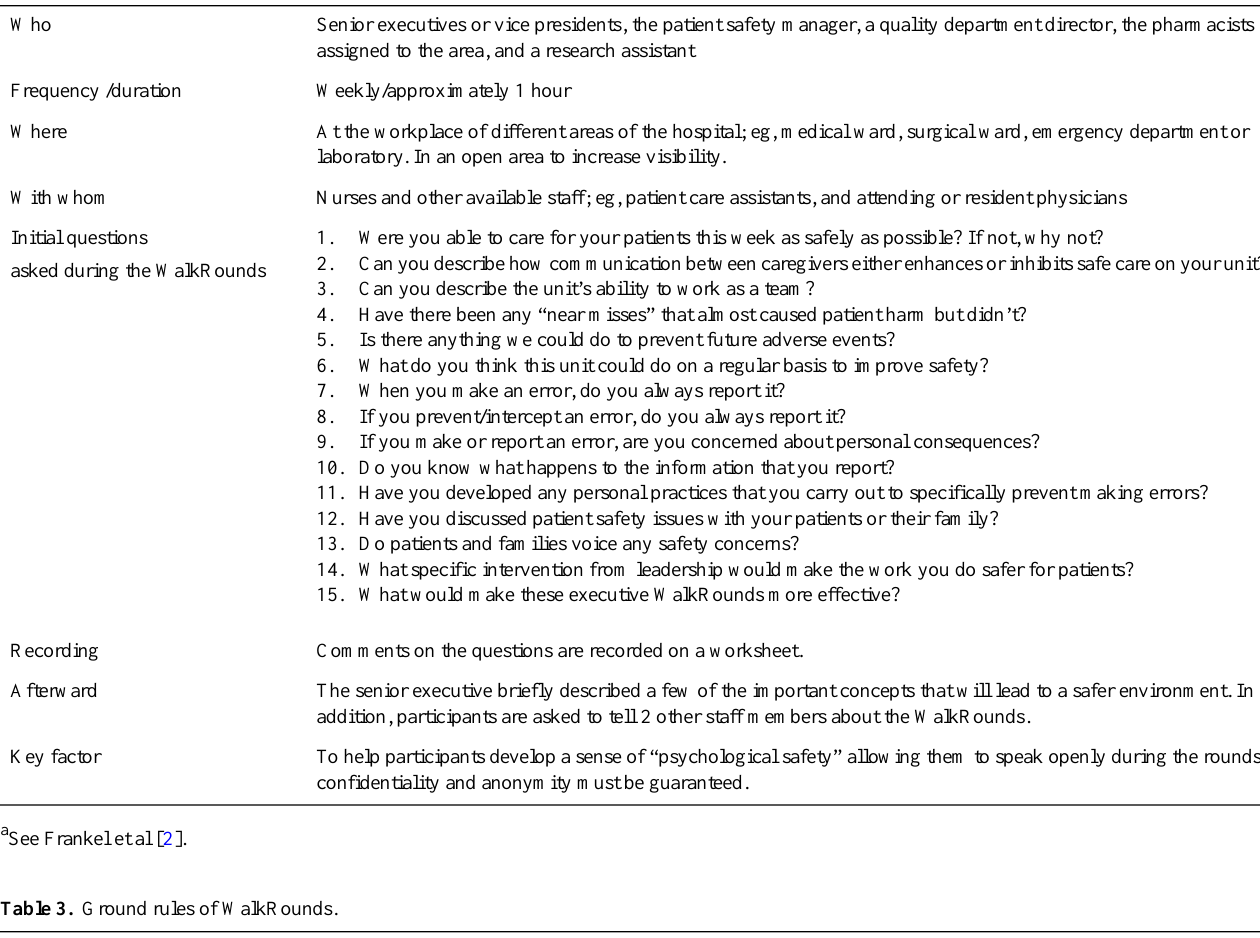
Senior executives or vice presidents, the patient safety manager, a quality department director, the pharmacists assistantWho assigned to the area, and a research